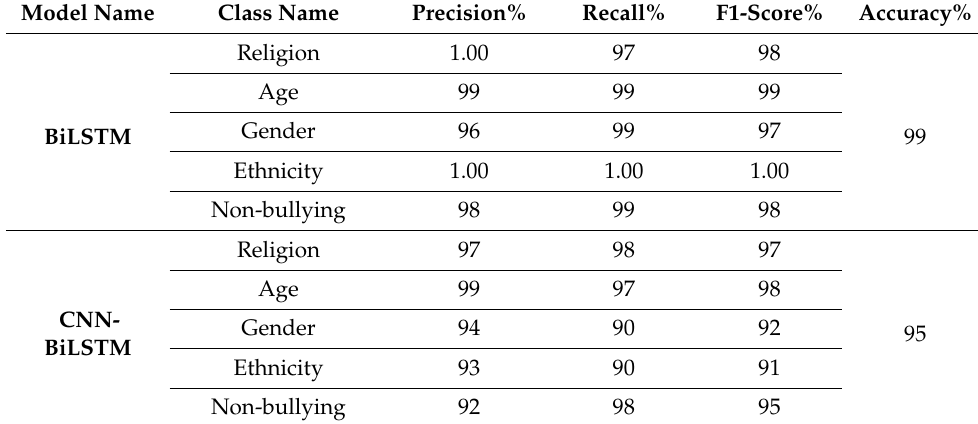
Table 4. Results for the BiLSTM and CNN-BiLSTM models using the multiclass dataset.